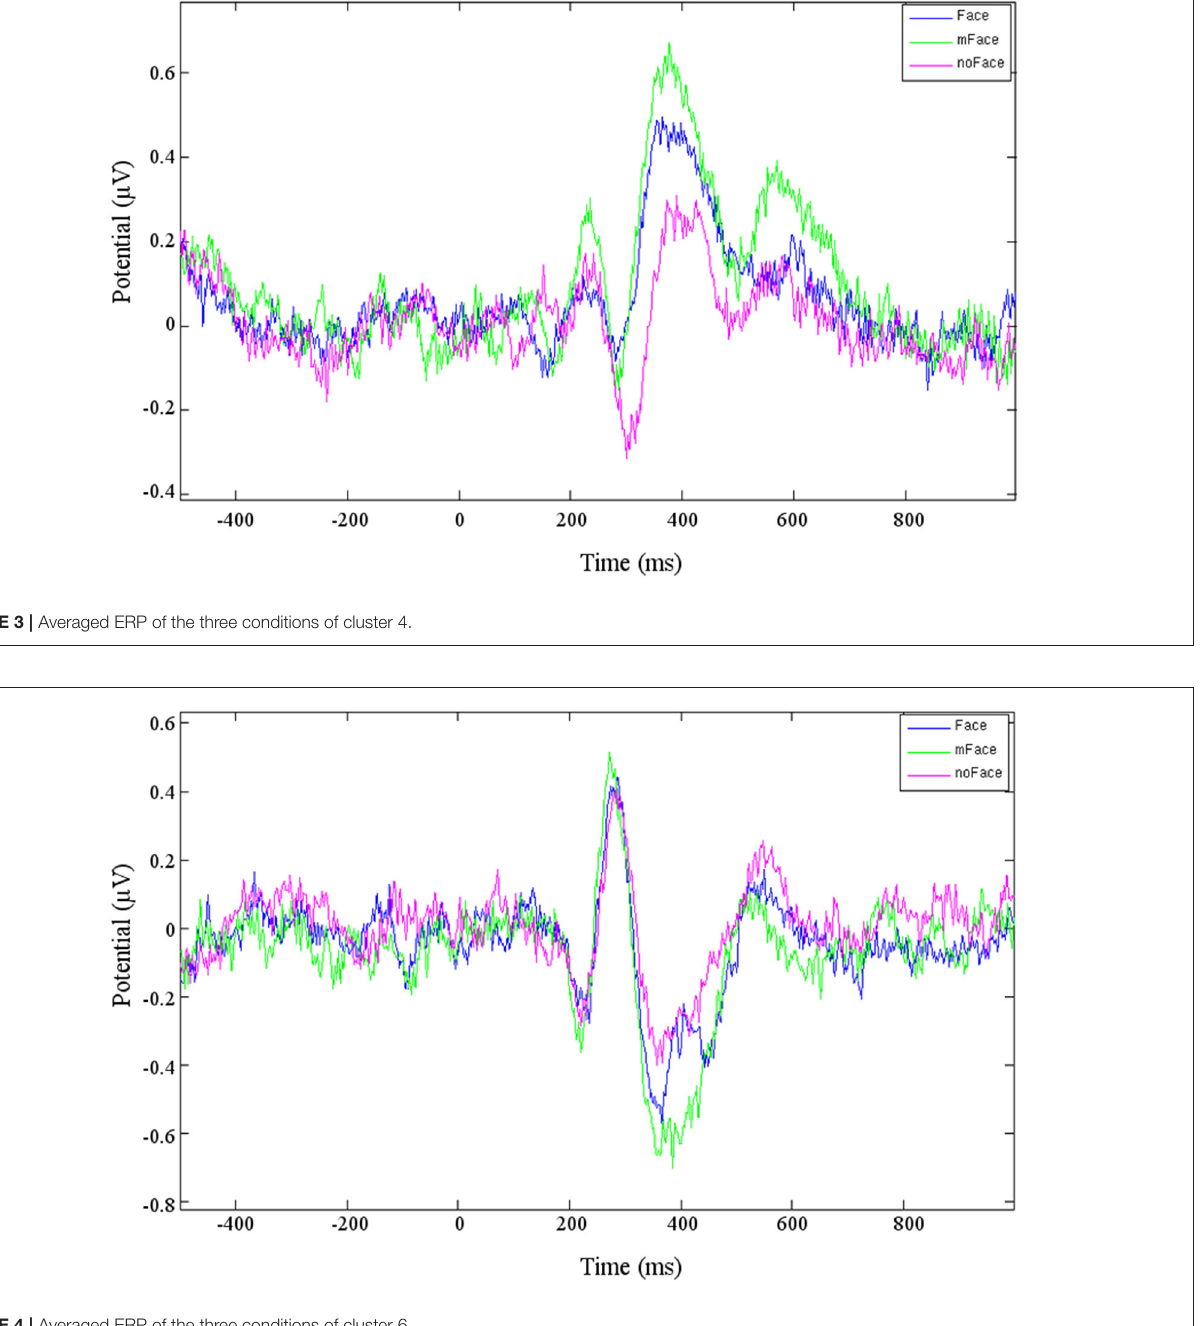
FIGURE 4 | Averaged ERP of the three conditions of cluster 6.